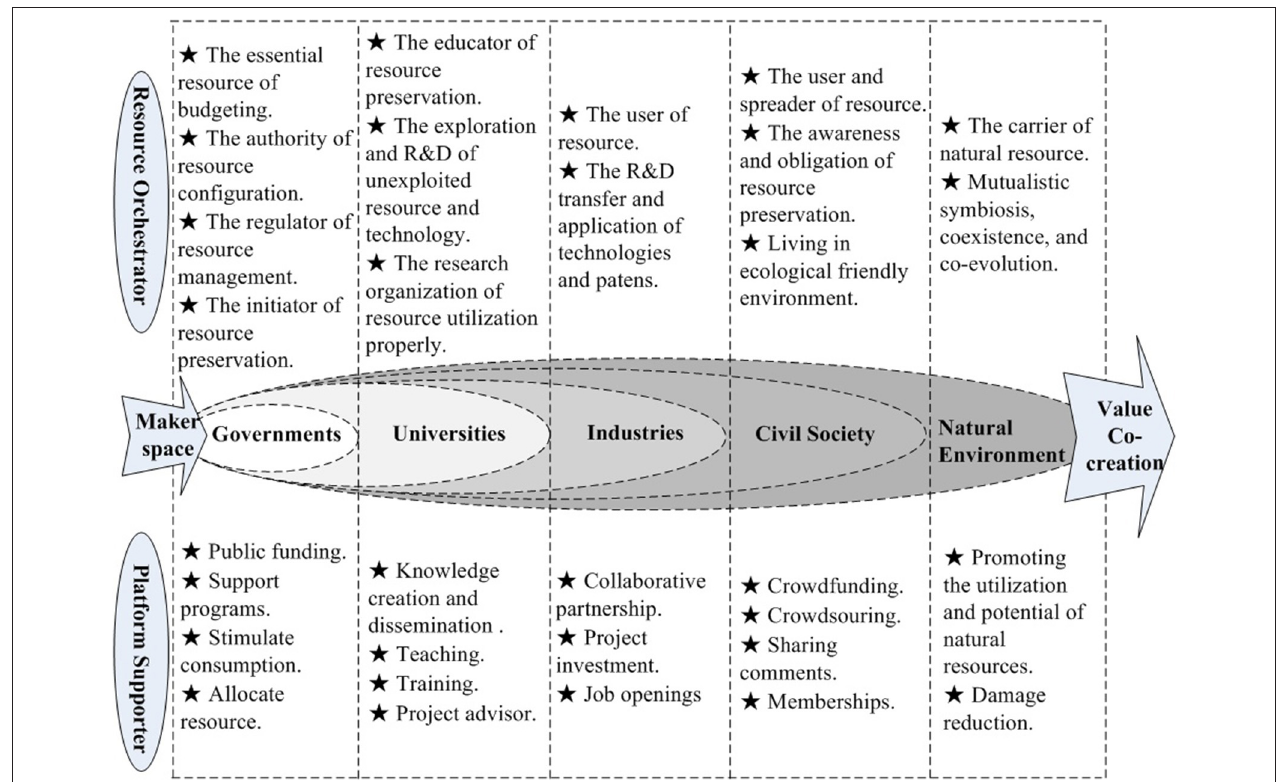
FIGURE 8 | Makerspaces as resource orchestrator and platform